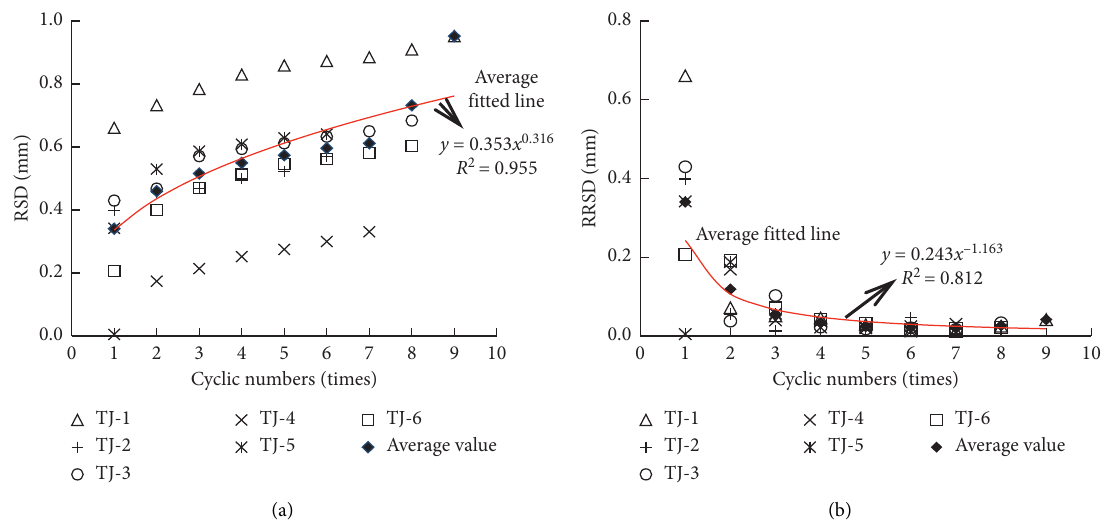
Figure 9: The shear displacement at different cycles numbers. (a) Residual shear displacement (RSD). (b) Relative residual shear dis- placement